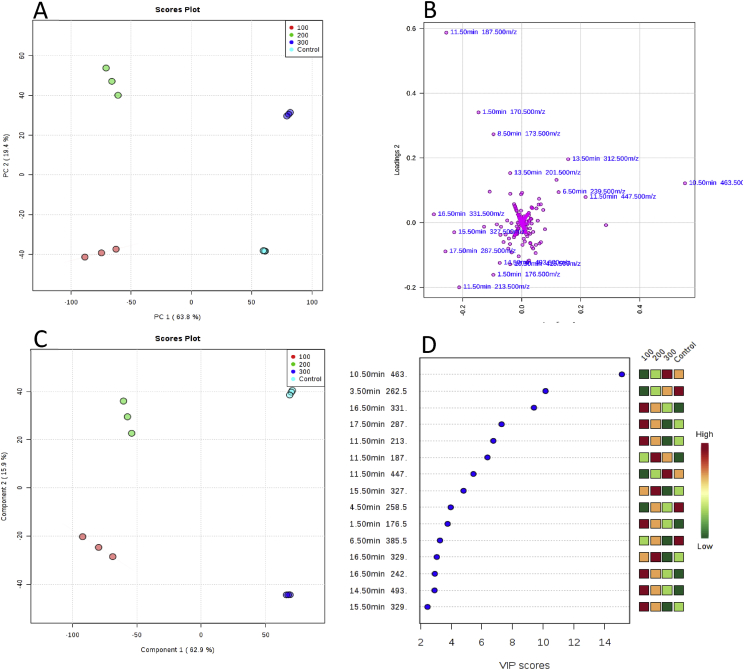
(A) PCA scores plot based on UHPLC−MS data showing separation amongst samples from different irrigation conditions (0 mM - Light Blue; 100 mM – Red; 200 mM – Green; and 300 mM - Deep Blue) for the 1st harvest, together with their respective 95% confidence regions. The explained variances are shown in brackets (PC 1 and PC 2: 63.8 and 19.4%, respectively). (B) The corresponding loadings scatter plot showing the compounds (represented by their retention times [RT]) that are correlated to separation in scores plot. (C) PLS-DA of metabolites between groups described above (component 1 and component 2: 62.9 and 15.9%, respectively). (D) Variables important in projection (VIP) scores of 15 top contributors (shown as RT) to PLS-DA component 1.